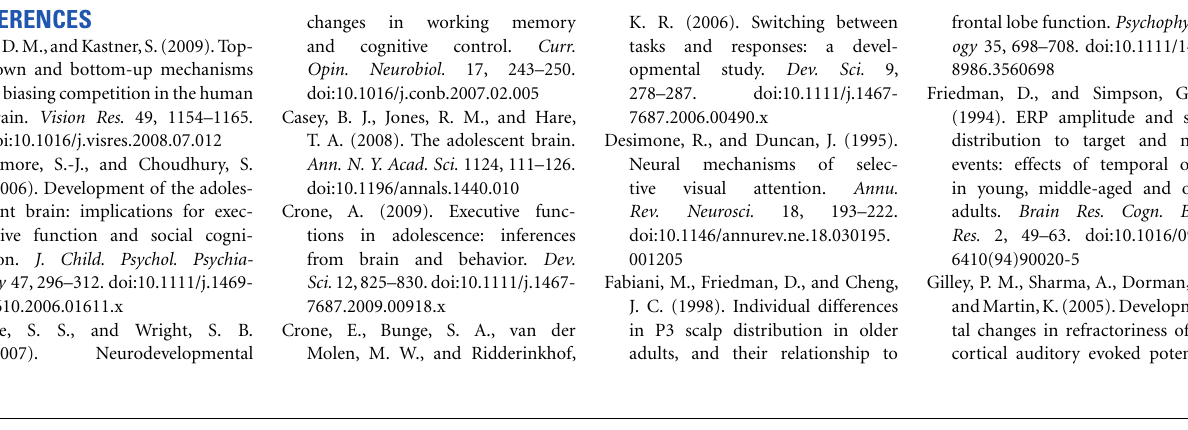
FIGURE 4 | Difference waveforms and scalp voltage maps for all conditions . (A) Difference waveforms (top row) are displayed for the target tones (thick lines) and B tones (thin lines) at Fz (solid line) and the left mastoid (LM, dashed lines) in the Attend-Pattern (left column), Attend-Pitch (middle column), and Attend-Video (right column). (B) Scalp voltage maps (middle row) are displayed at the peak of the ERP components (peak latency above